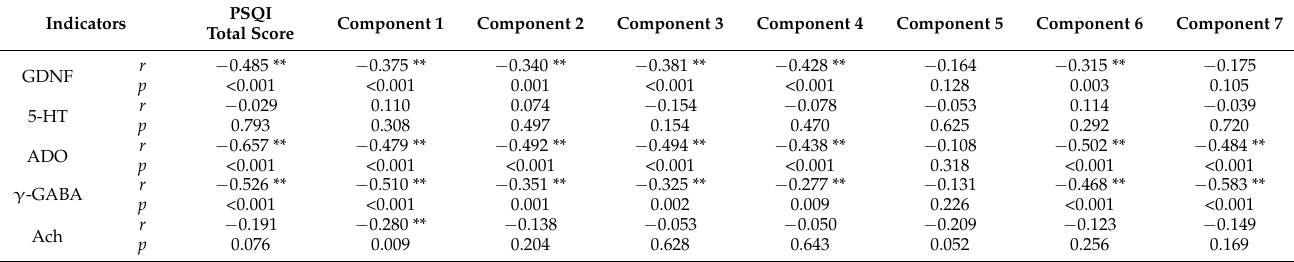
Table 4. Correlation between ADO, GDNF, γ -GABA, 5-HT, Ach, and PSQI scale.